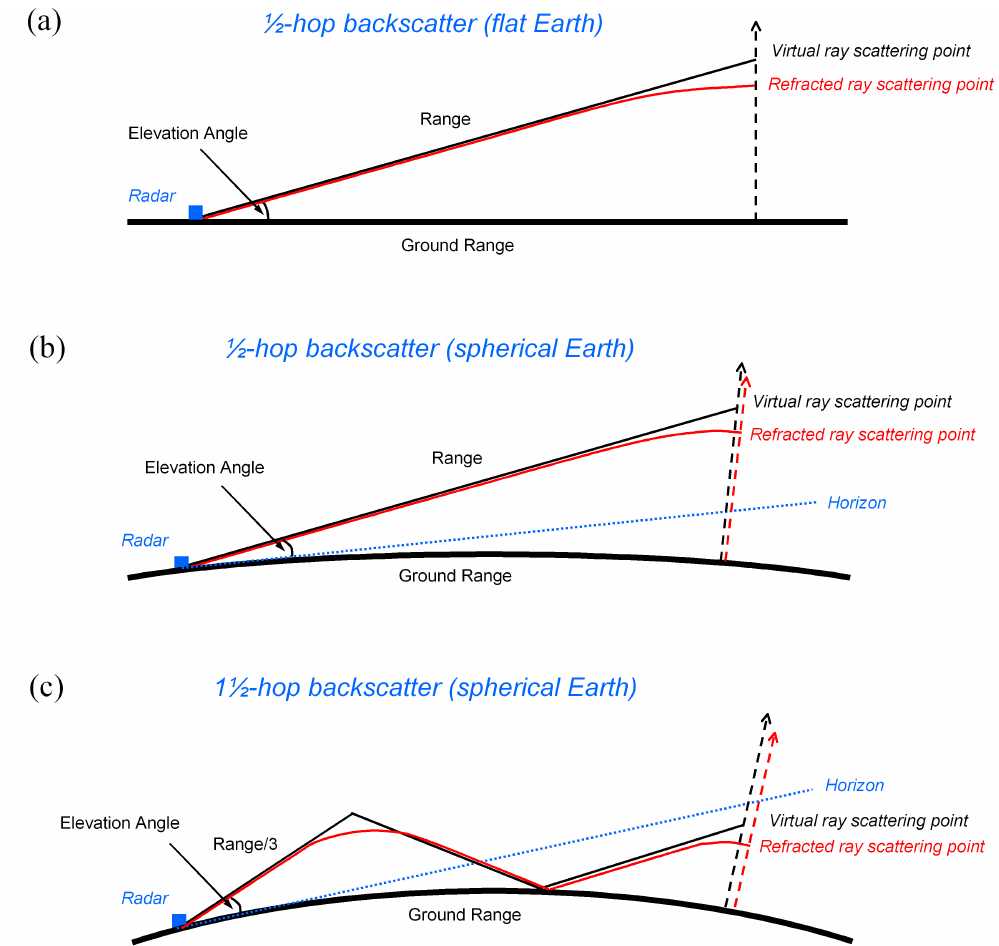
2 -hop ionospheric backscatter assuming a spherical Earth.